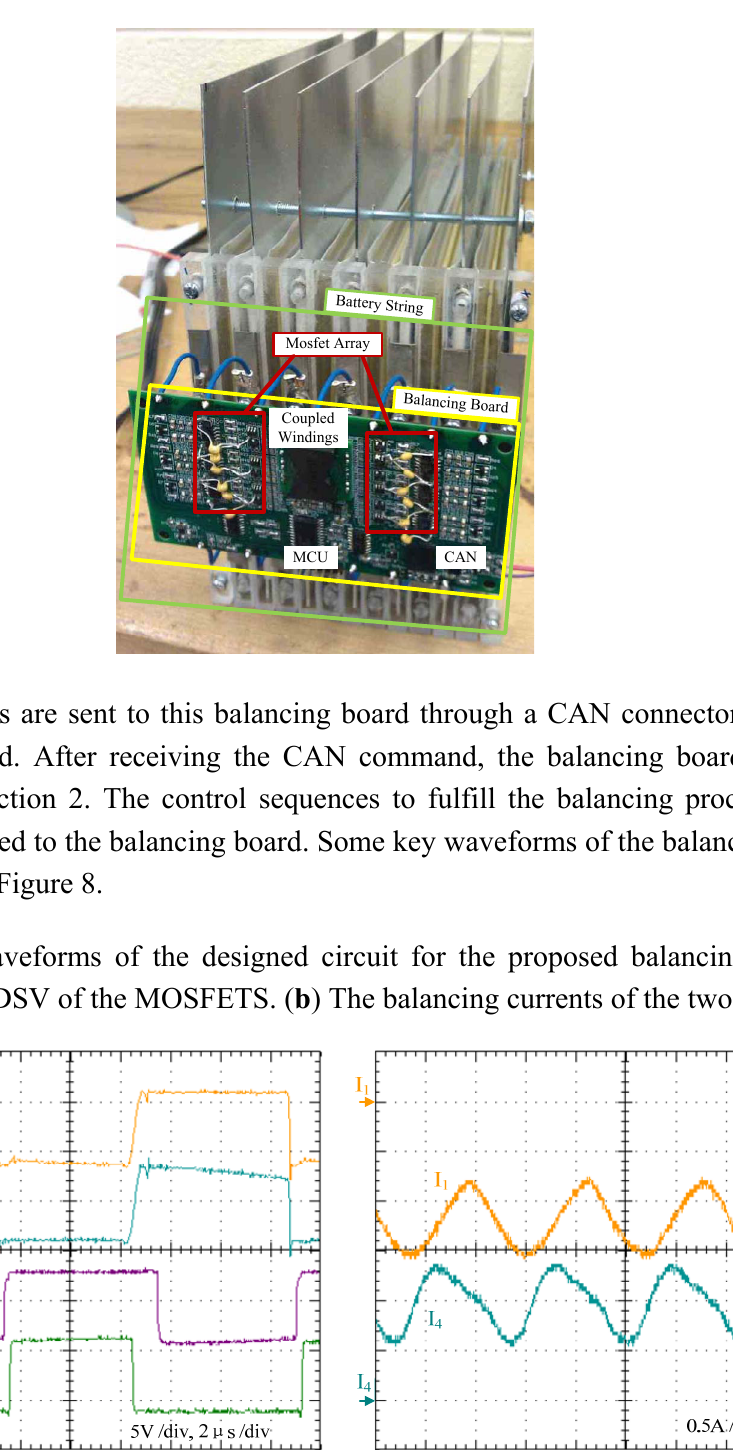
Figure 7. Designed circuit for the proposed balancing topology.